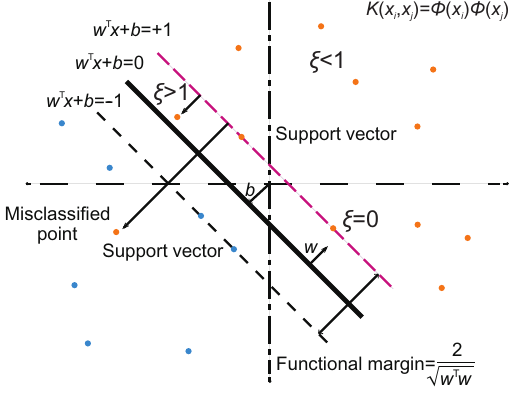
Fig. 1 A linear support vector machine. Fig. 2 Overview of our